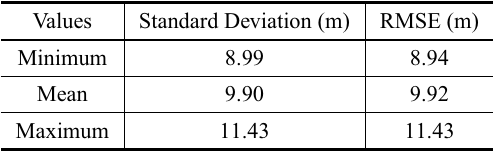
Mean, minimum and maximum values of Standard Deviation and RMSE for all extracted